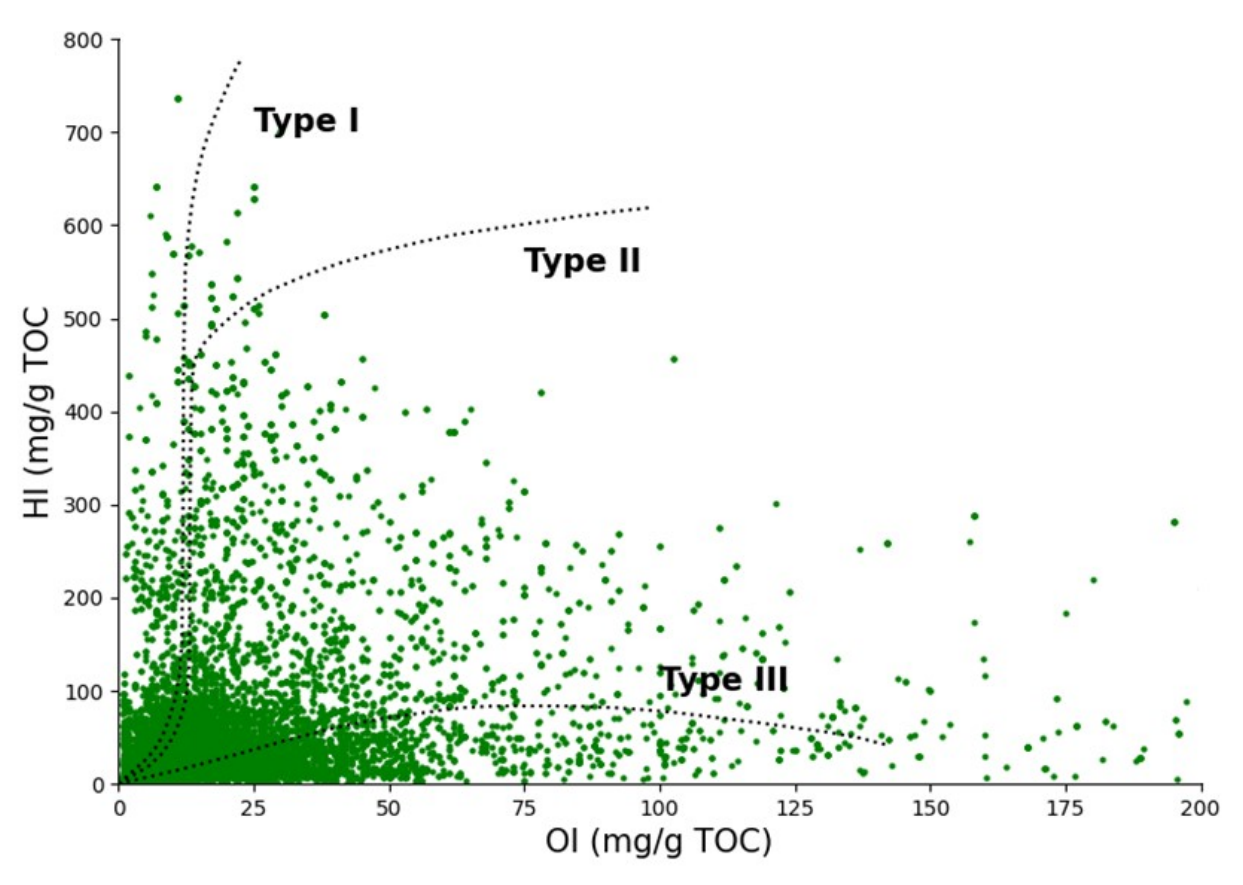
Figure 10. Pseudo-Van Krevelen plot of Montney Formation Rock Eval analyses. The plot shows a large variability in kerogen types across the entire formation, which is not surprising, as the Montney Formation would represent many depositional environments (i.e., offshore deep water, nearshore bioclastic shorelines) and maturation levels. Kerogen that contains low HI and OI are due to the high transformation ratio experienced in areas of high maturation (high Tmax values).